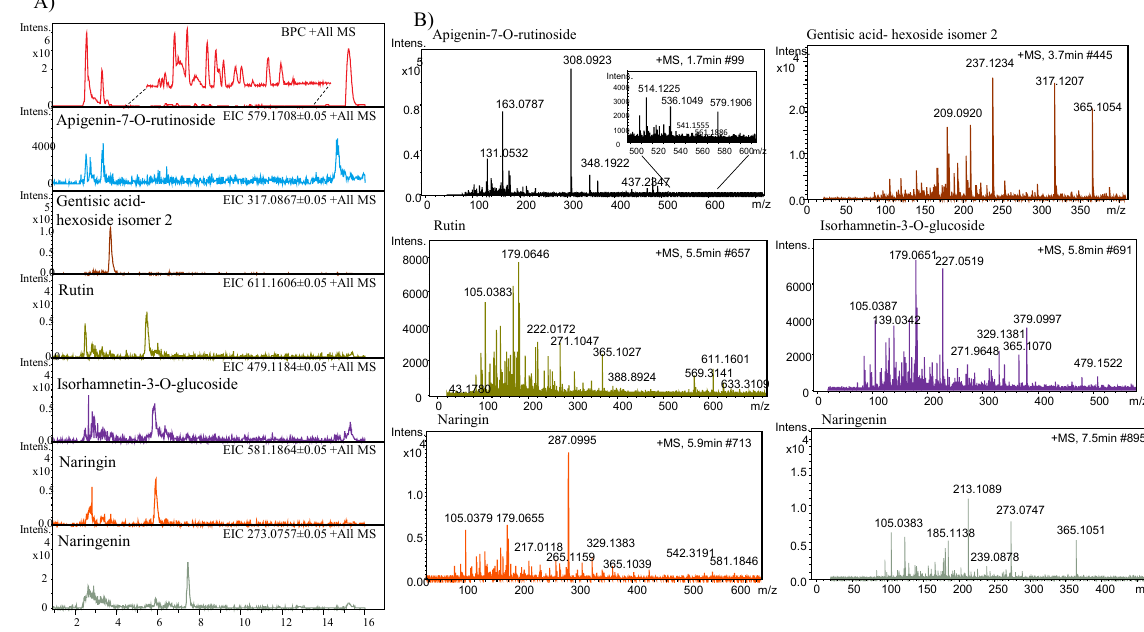
Figure 5. ( A ) Total ion chromatogram and extracted ion chromatograms by LC-HR-ESI-QTOF-MS and ( B ) tandem mass spectra of phenolic compounds identified from the methanol extracts of melon.